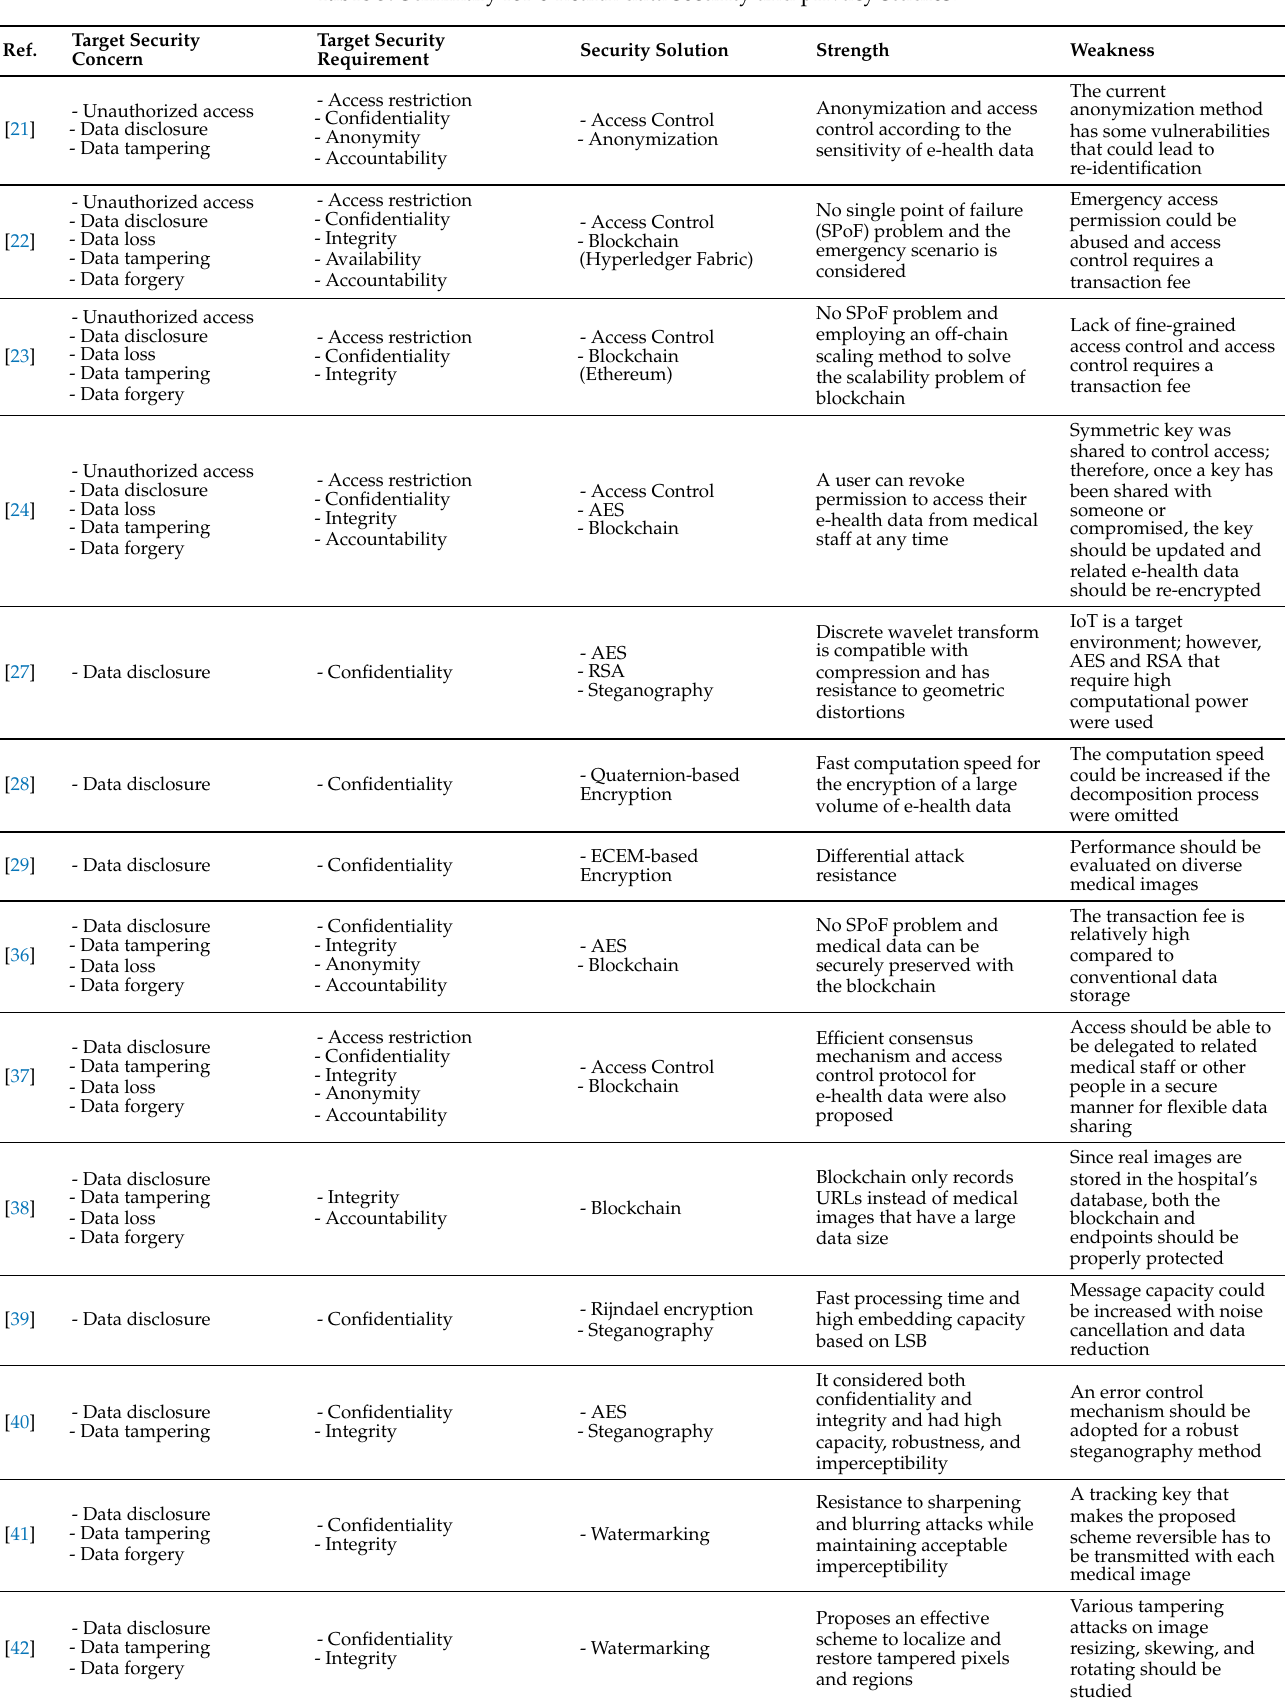
Table 3. Summary for e-health data security and privacy